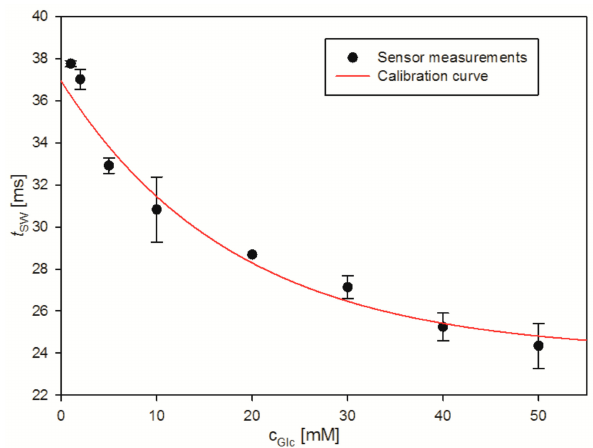
Figure 4. Calibration curve measured before the cultivation monitoring experiment in Noack medium with defined glucose concentrations between 1 and 50 mM during 6.5 h.